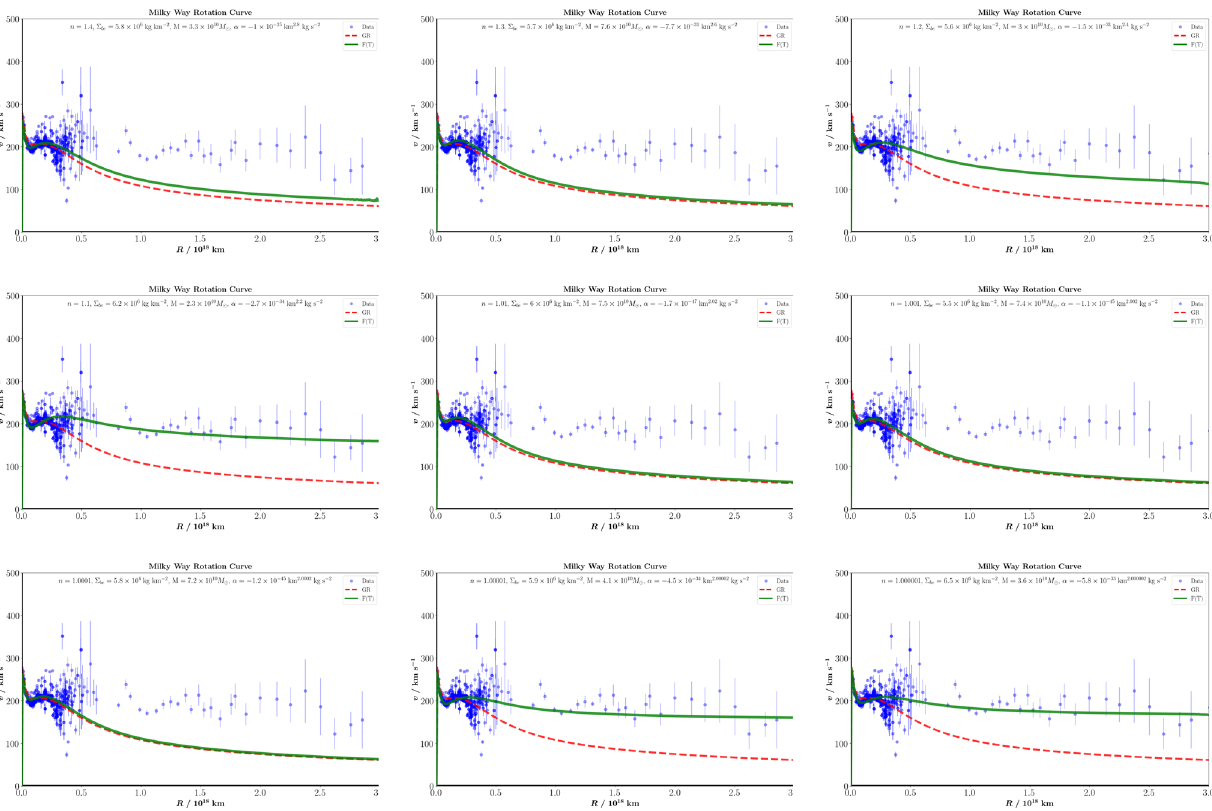
Fig. 4 f ( T ) gravity rotational velocities with n values ranging from 1 . 4 to 1 . 000001, with a fitted bulge surface mass density (cid:4) be , disk mass M and coupling constant α Fig. 5 Best fit model for the rotation profile in f ( T ) gravity for the Milky Way galaxy with n = 1 . 00001 and fit coupling parameter α = − 4 . 51 × − 34 km 2 n kg − 1 s − 2 , bulge surface mass density of 5 . 94 × 10 6 kg km − 2 and disk mass 4 . 08 × 10 10 M